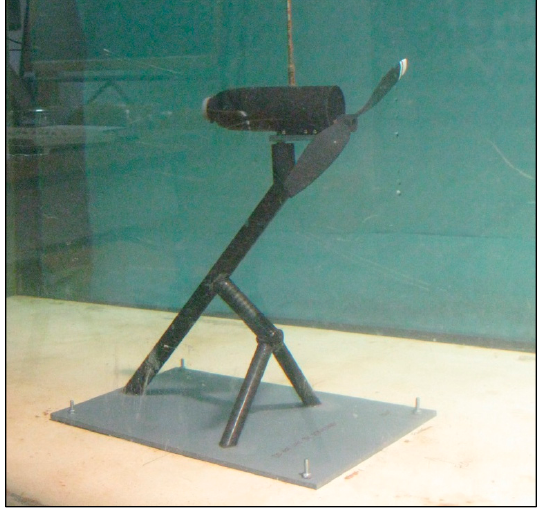
Figure 15. Universal turbine model in situ during an S1 test.